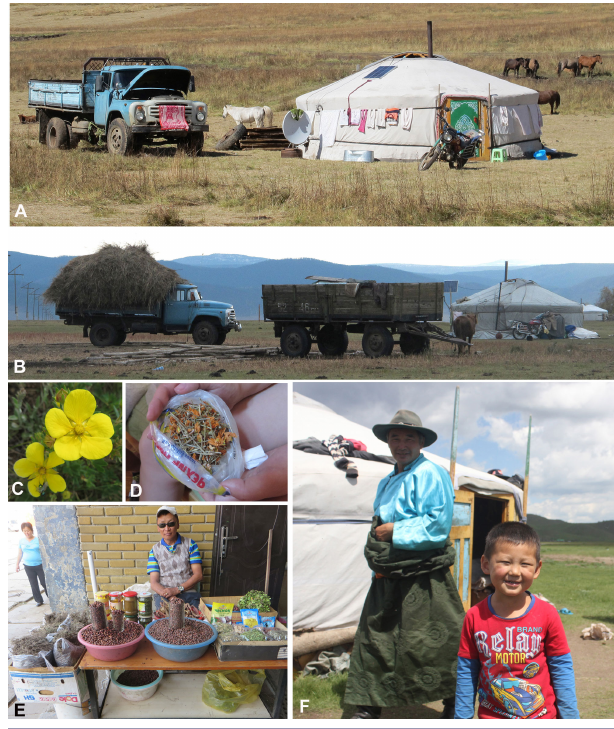
Fig. 3 . Examples of biocultural diversity and change in the Mongolian pastoralist context (Seele 2017). Although the ger and homestead remain at the center of pastoralist life, pivotal changes in material culture, the mobility of livestock, and knowledge exchange reflect the interplay between changes in biodiversity at multiple scales and changes in the cultural uses of the environment. (A) The shift from horses to trucks and motorbikes has stimulated biocultural change; (B) A decrease in nomadic mobility and pasture rotation can mean having to bring in fodder by truck, and (C) fewer opportunities for harvesting fresh medicinal plants in different areas. As a result, (D) the storage of medicinal plants in plastic bags is now common and (E) herbal medicines can also be bought in larger settlements; (F) Although changes in dress between generations is clear, the effects of changes in intergenerational knowledge transfer are less so. Photo credits: A-E: B. Seele; F: H.